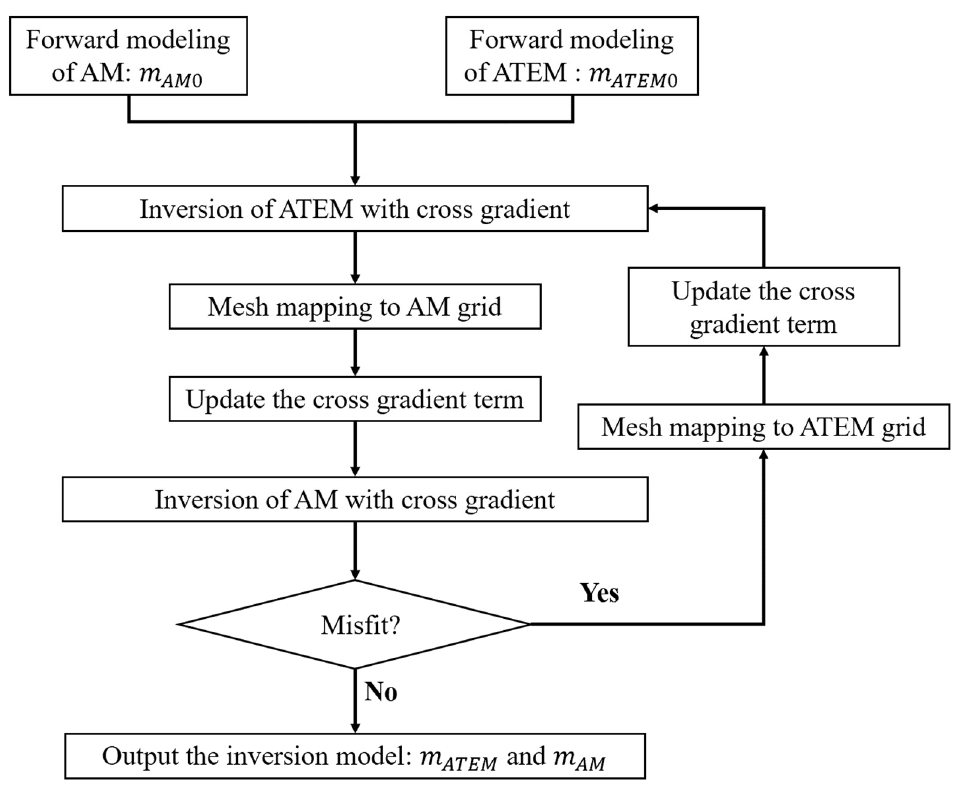
Figure 8. Flow diagram of the cooperative inversion method.